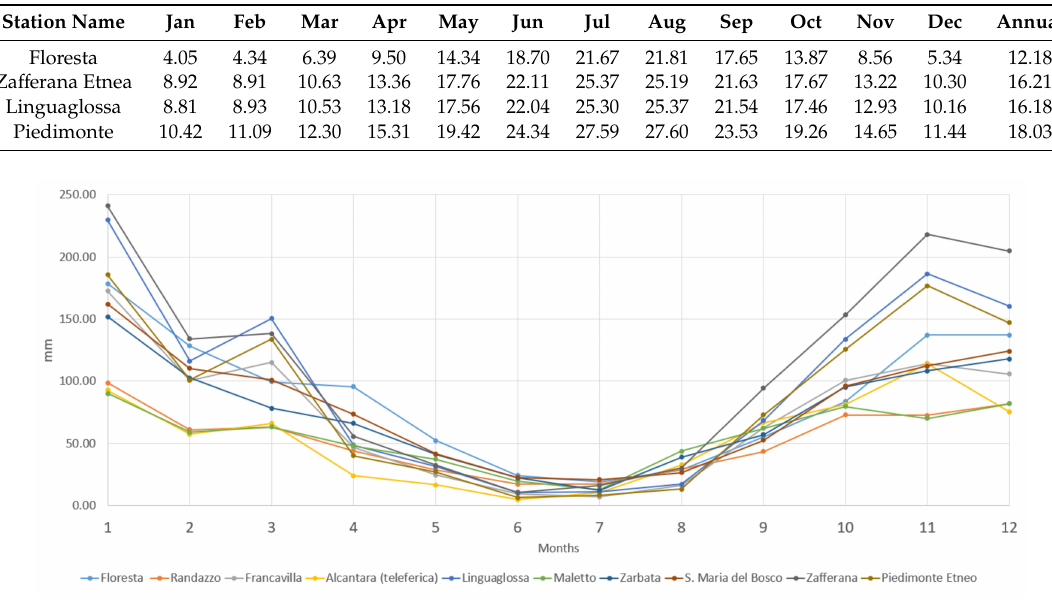
Figure 2. Mean monthly rainfall